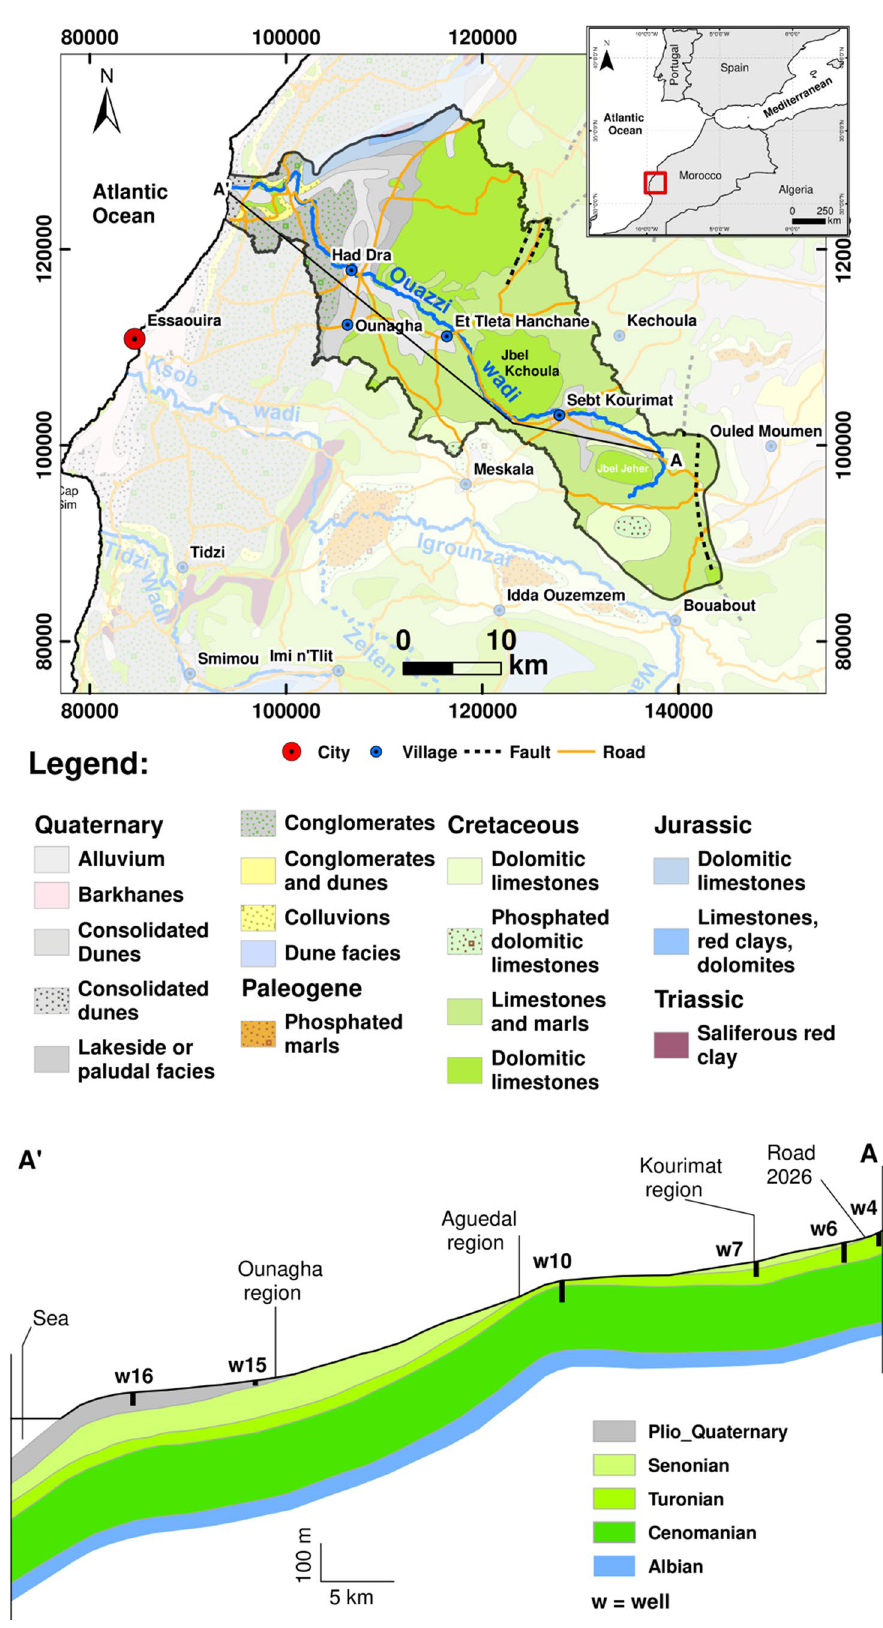
Fig. 1 Geographic location, geological map, and cross sec- tion of the study